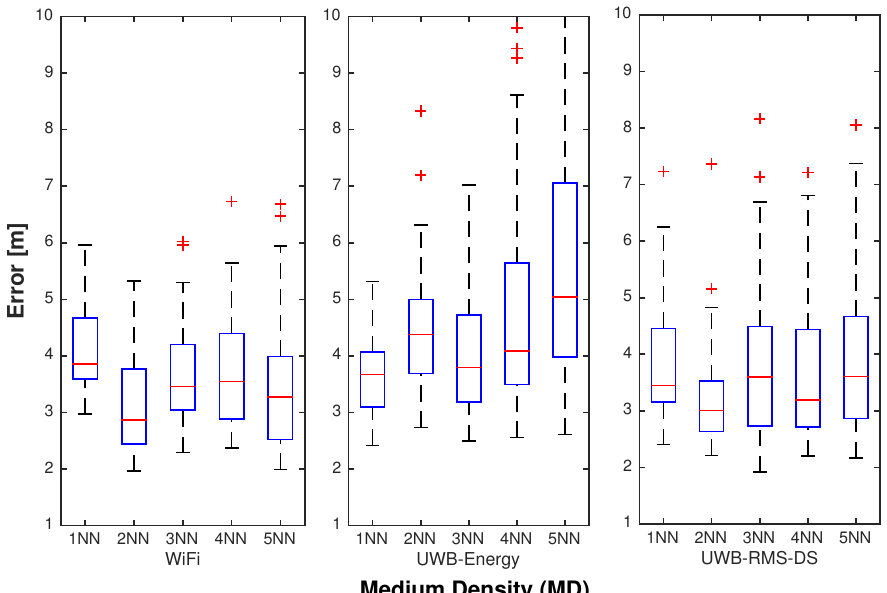
Figure 4. Statistics of positioning error (cid:101) in medium density (MD) scenario for WiFi, ultra-wideband (UWB)-energy and UWB root-mean-square delay spread (RMS-DS) with fixed k -nearest neighbor ( k NN) algorithm ( k = { 1,2,3,4,5 } ).